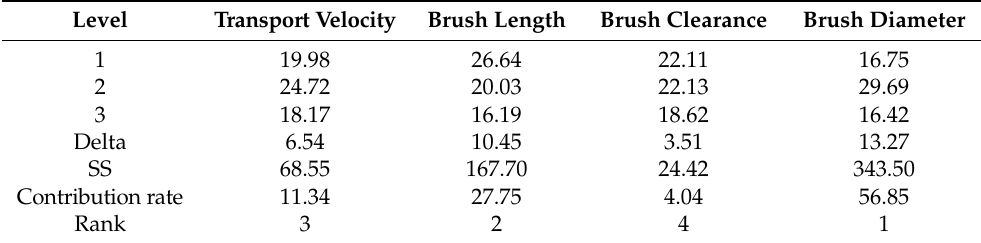
Table 5. Response table for elimination S/N ratios of circular-shaped cherry tomato.